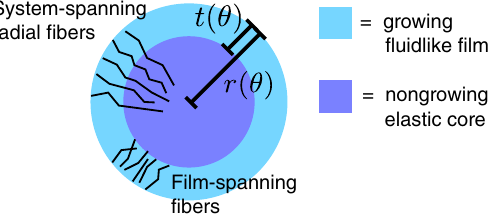
FIG. 3. Idealized, parasaggital section of an embryonic cer- ebellum. The cortex is modeled as a growing fluidlike “ film. ” Bergmann glia fibers span this film, while radial glia fibers span the structure. Periodic boundary conditions are likely not relevant to a real cerebellum, whose cortex is discontinuous owing to a ventricular zone and attachment to the brain stem, but they will be adopted here for